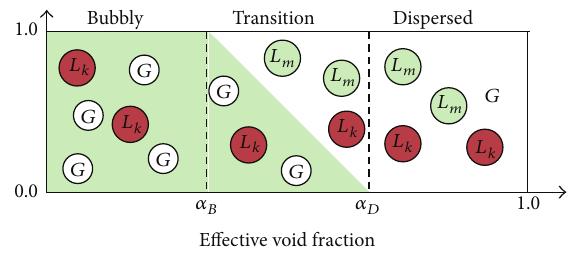
Figure 4: Pool flow regime map in SIMMER-III.